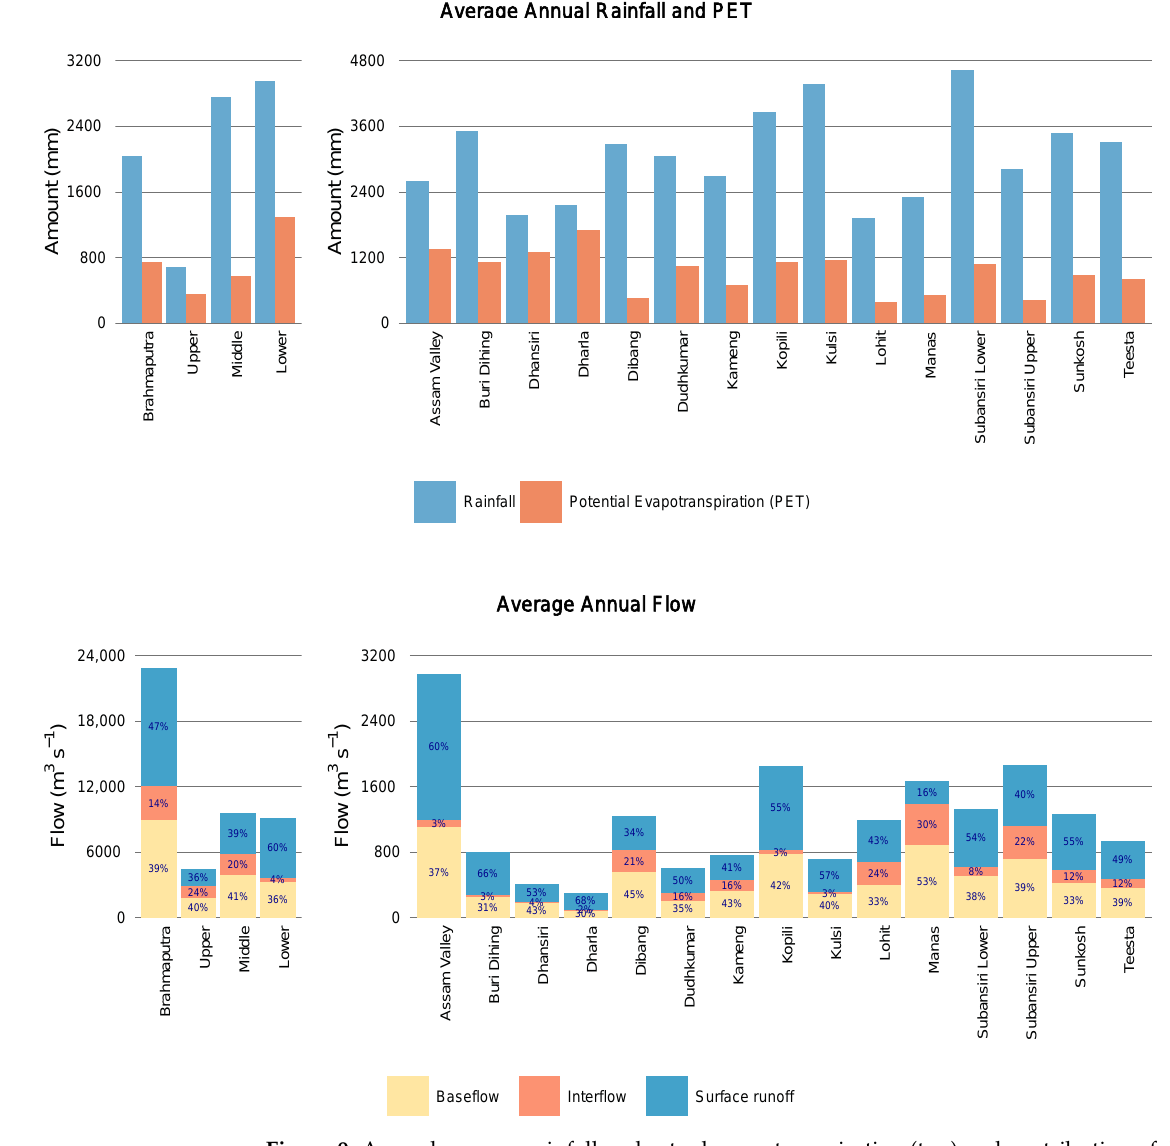
Figure 9. Annual average rainfall and actual evapotranspiration (top) and contribution of different flow components to annual water yield (bottom) of the Brahmaputra River Basin in